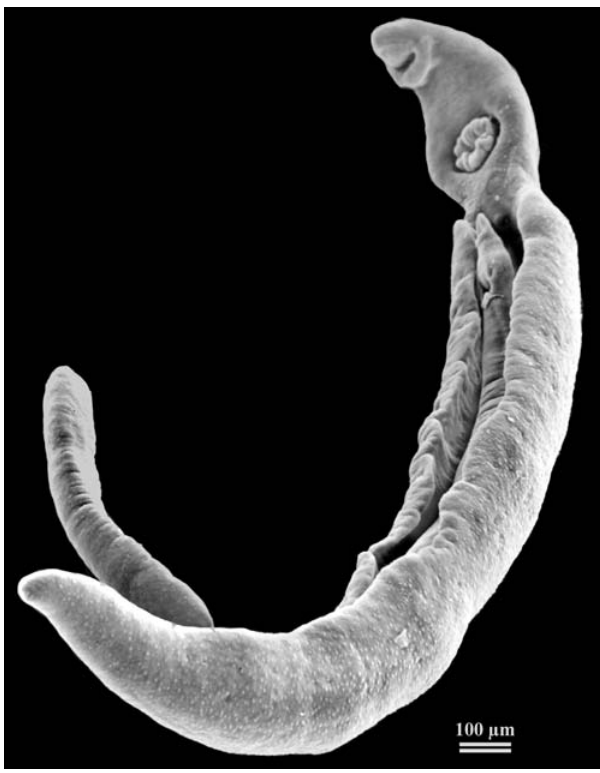
Figure 1. A schistosome pair, with the thin female located in the male gynaecophorical canal.